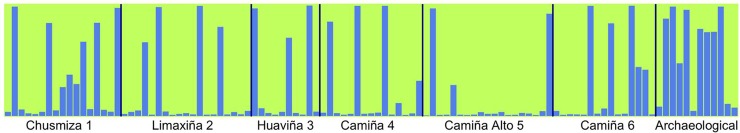
Estimated population structure.Each population assigned in the lower part of the graphic. The graphic is portioned into K = 2 colored segments (green and red segments). The population are separated by black bars and labeled above the figure.